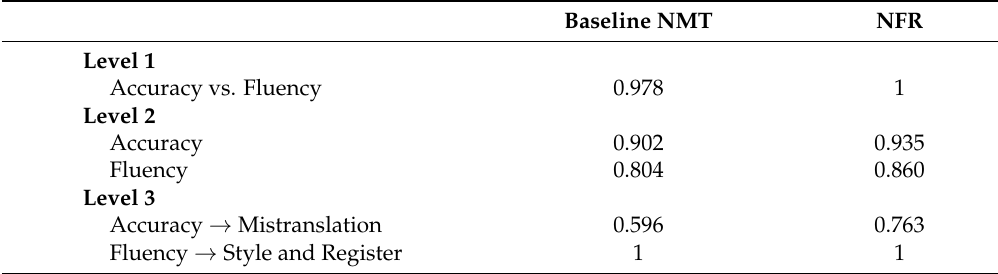
Table 4. Kappa scores for inter-annotator agreement on error classification at the three levels of the error